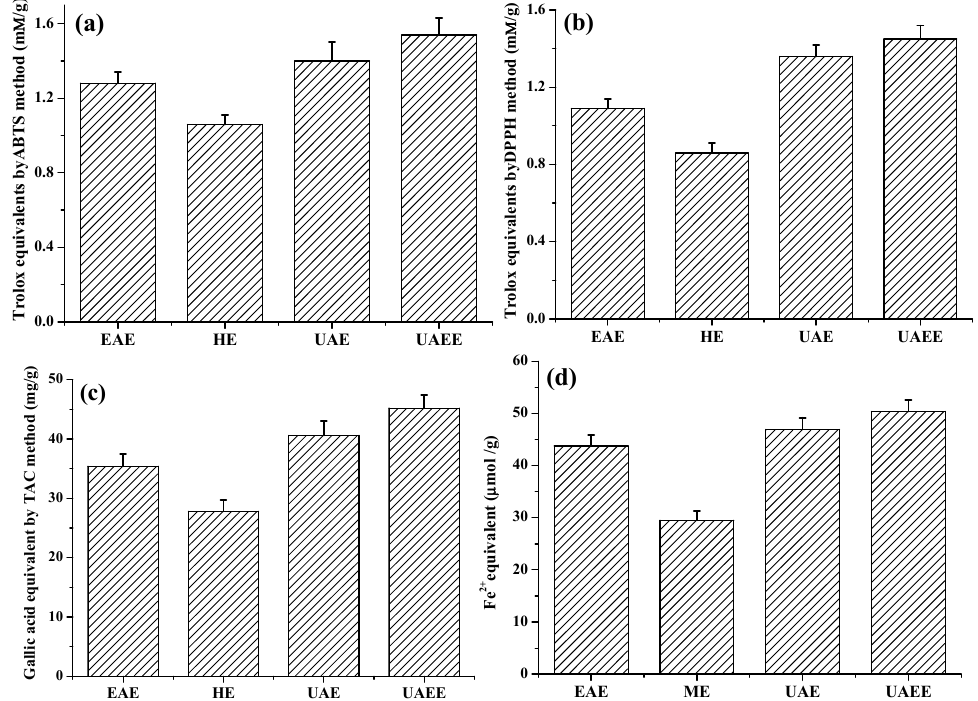
Figure 4. Antioxidant activity of phenolic extracts obtained from different methods: ( a ) ABTS (mmol Trolox equivalent/g dry weight); ( b ) DPPH (mmol Trolox equivalent/g dry weight); ( c ) FRAP (mg Gallic acid equivalent/g dry weight); and ( d ) FRAC ( μ mol FeSO 4 equivalent/g dry weight).